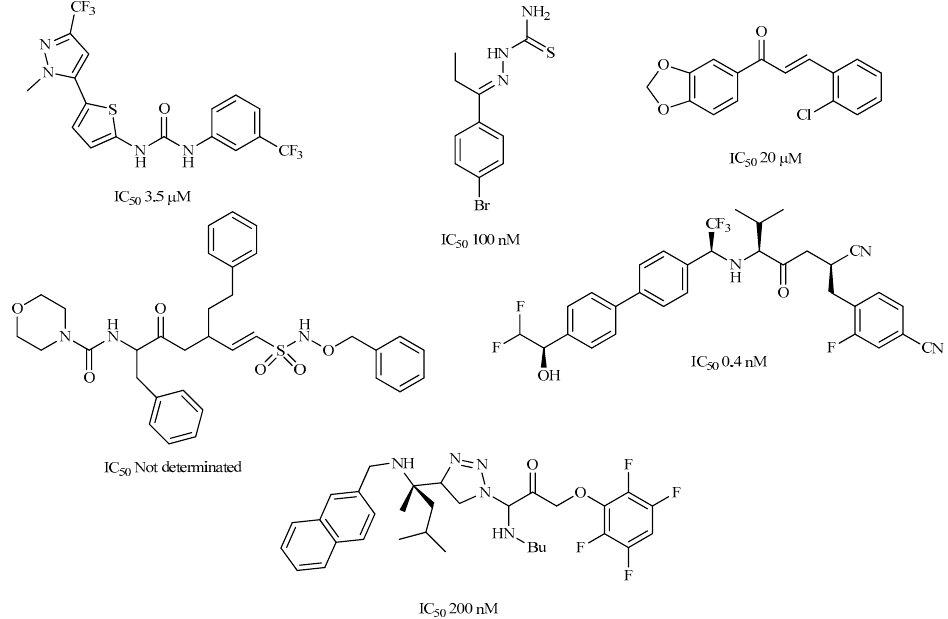
Figure 1. Chemical structure of urea, thiocarbazone, chalcone, amide, nitrile, and hydrazine derivatives identified as Cz